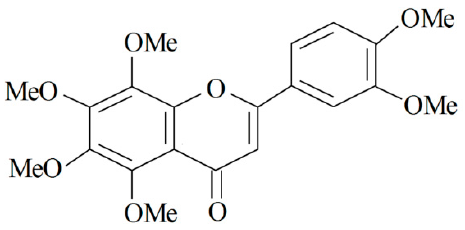
Figure 1. Chemical structure of 5,6,7,8,3 ′ ,4 ′ -hexamethoxyflavone (nobiletin, NOB).